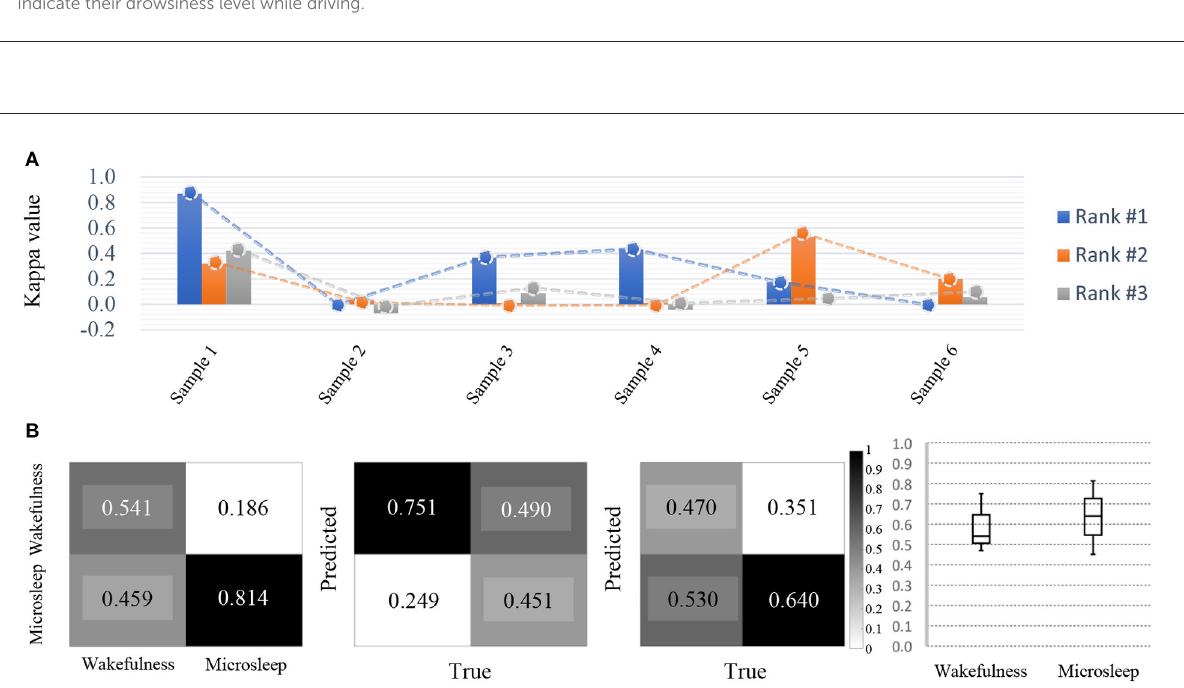
FIGURE5 Experimental setup and protocol corresponding to validation and test data. (A) Provides an experimental environment that simulates 3D driving while wearing the EEG cap. (B) Locations of electrodes for recording EEG. Pz and Oz were used to detect micro-sleep. (C) The experiment was conducted for approximately 1 h, and the subjects were evaluated based on the Karolinska sleepiness scale (KSS) 13 times, which was used to indicate their drowsiness level while driving.